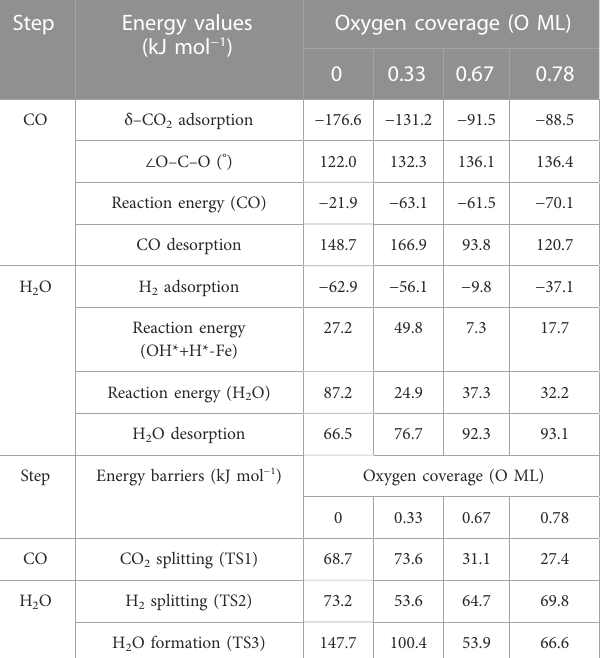
group adsorbed to the Mo-hollow site. The geometries of TS3 are similar for all coverages. The main differences observed are the position of the OH* group, the migration site of the H* atom, and the distance length when migrating from the Cu/Mo 2 C interface to OH*. Table 4 summarizes the related position/migration and the Cu – H and O – H bond lengths for TS3. In this case, the bond length of the H* atom to Cu of the interface allows a higher reactivity of this hydrogen atom, resulting in a lower energy barrier. Structures of initial state (IS), transition state (TS), intermediate, and fi nal state (FS) are shown in Figure 10.